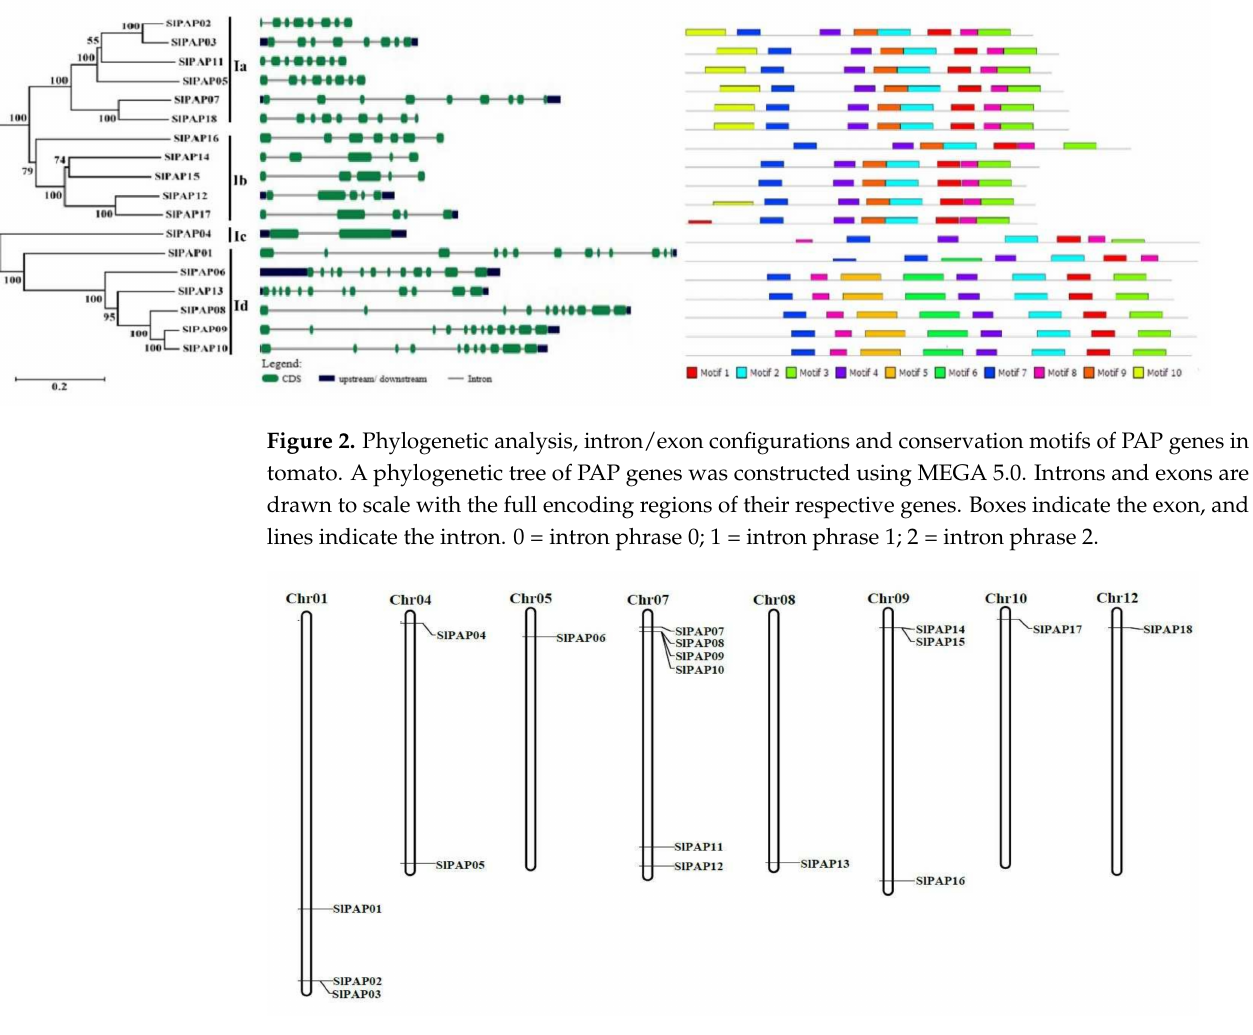
Figure 3. Position of SlPAP genes on the tomato chromosomes. Chromosome numbers are indicated at the top of the